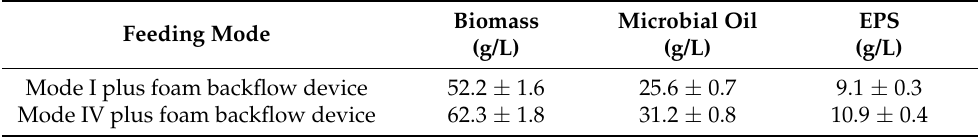
Table 3. Effect of foam return device on the fermentation of S. pararoseus